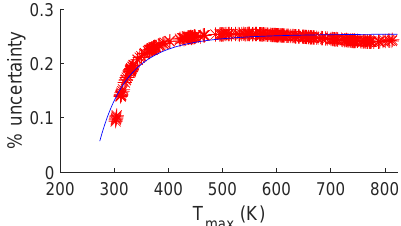
Figure A3. Trend of percent uncertainty for different maximum temperature values; red points indicate data, blue line indicates fitted